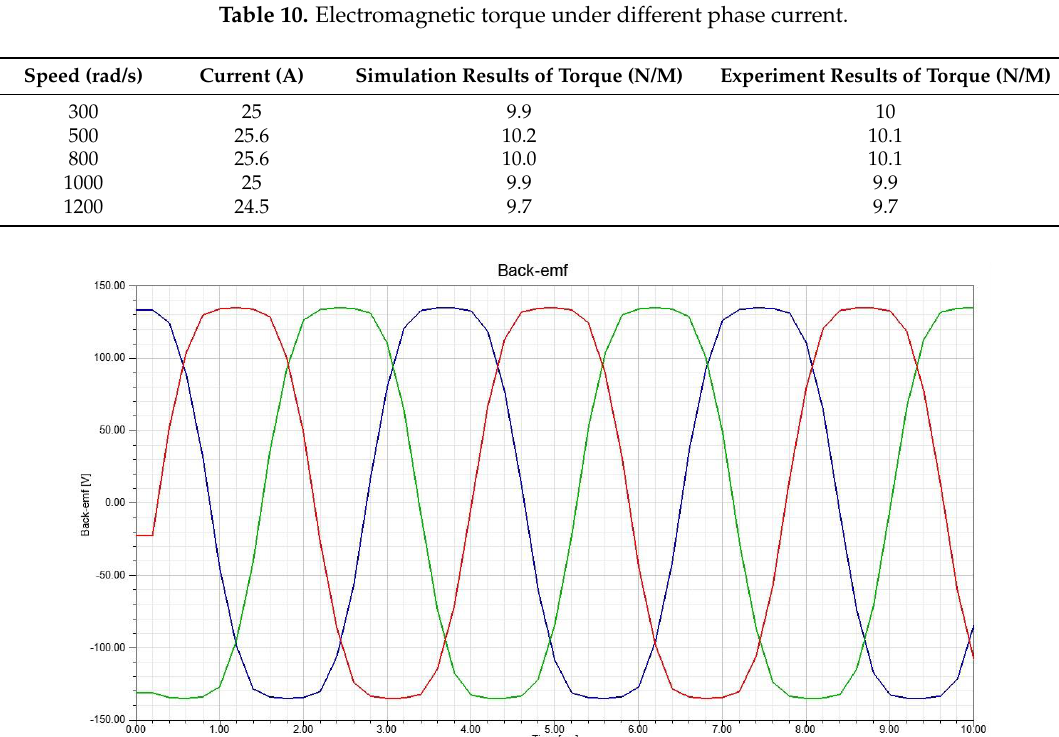
Figure 14. No-load back electromotive force.